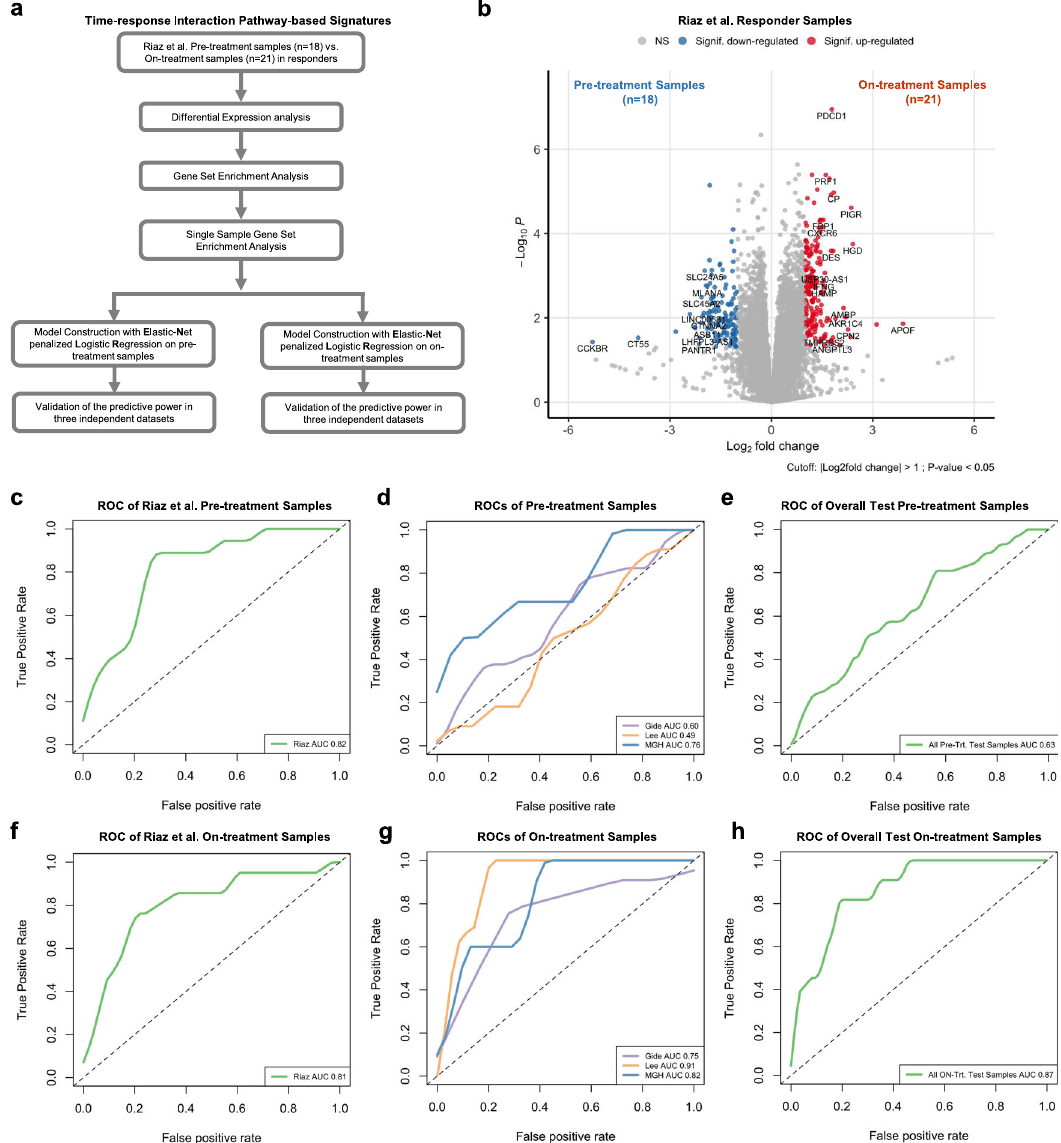
Fig. 6 Time-response interaction pathway-based super signatures for pre- and on-treatment samples. a Computation pipeline of model construction of time-response interaction pathway-based Super Signatures. b The volcano plot of differential gene expression analysis of response pre-treatment and on- treatment samples in the Riaz et al. cohort. Log2Fold change (FC) was calculated. The two-sided Wald test was implemented to test if no differential expression between response pre-treatment and on-treatment samples. The blue dots represent signi fi cantly downregulated (Signif. downregulated) genes (log2Fold Change < − 1, P -value < 0.05). The red dots represent signi fi cantly upregulated (Signif. upregulated) genes (log2Fold Change > 1, P -value < 0.05). The gray dots represent nonsigni fi cant (NS) genes. c – e ROCs and AUCs of the time-response interaction pathway-based super signatures for pre- treatment samples (TimeANLS-PRE) from Riaz et al. cohort ( c ), Gide et al., Lee et al., and MGH cohorts ( d ), combined pre-treatment with Gide et al., Lee et al., and MGH cohorts ( e ). f – h ROCs and AUCs of the time-respons e interaction pathway-based super signatures for on-treatment samples (TimeANLS- ON) from Riaz et al. cohort ( f ), Gide et al., Lee et al., and MGH cohorts ( g ), combined on-treatment with Gide et al., Lee et al., and MGH cohorts ( h ). Source data are provided as a Source Data fi